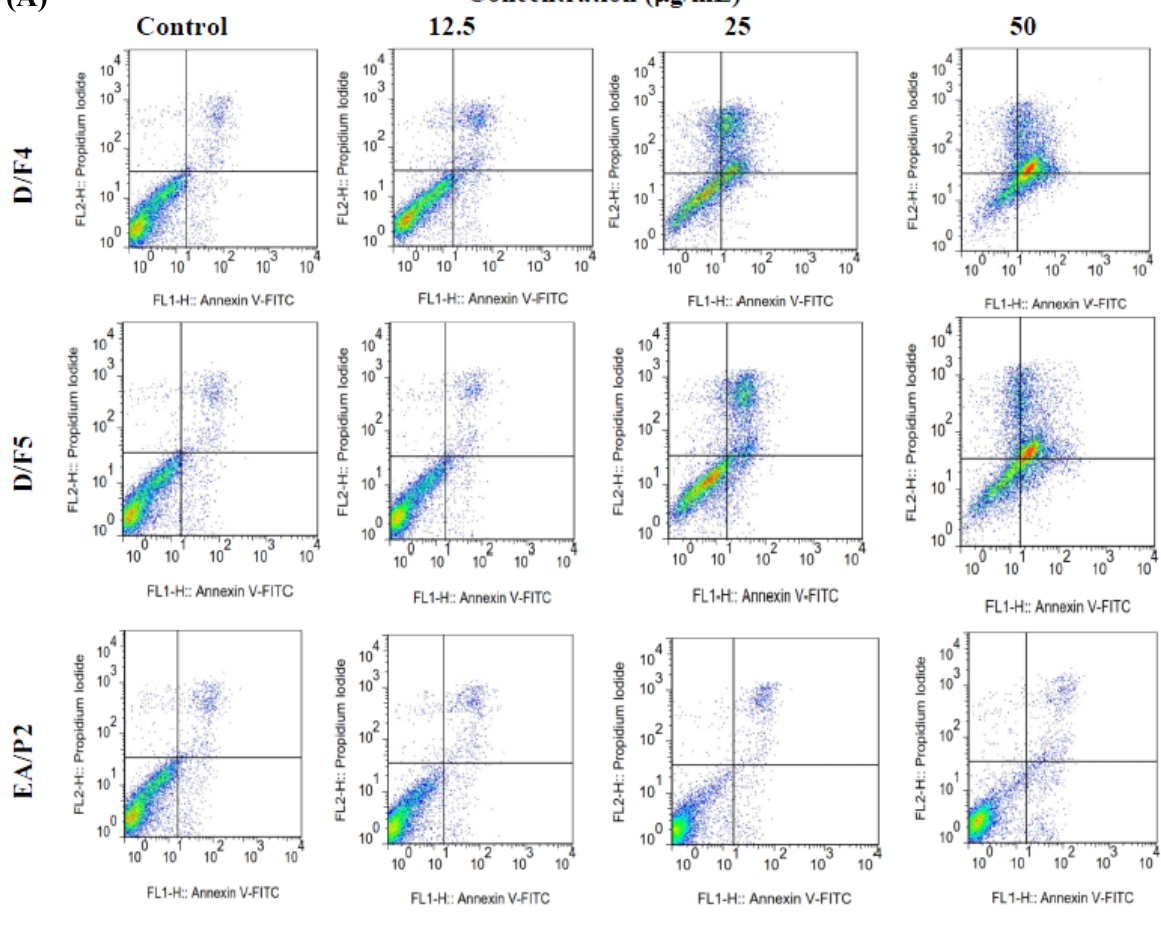
the dot plots ( C ) and the percentage (%) of cell distribution ( D ) of MDA-MB-231 after treated with the active fractions of D. suffruticosa (D/F4, D/F5 and EA/P2) as determined